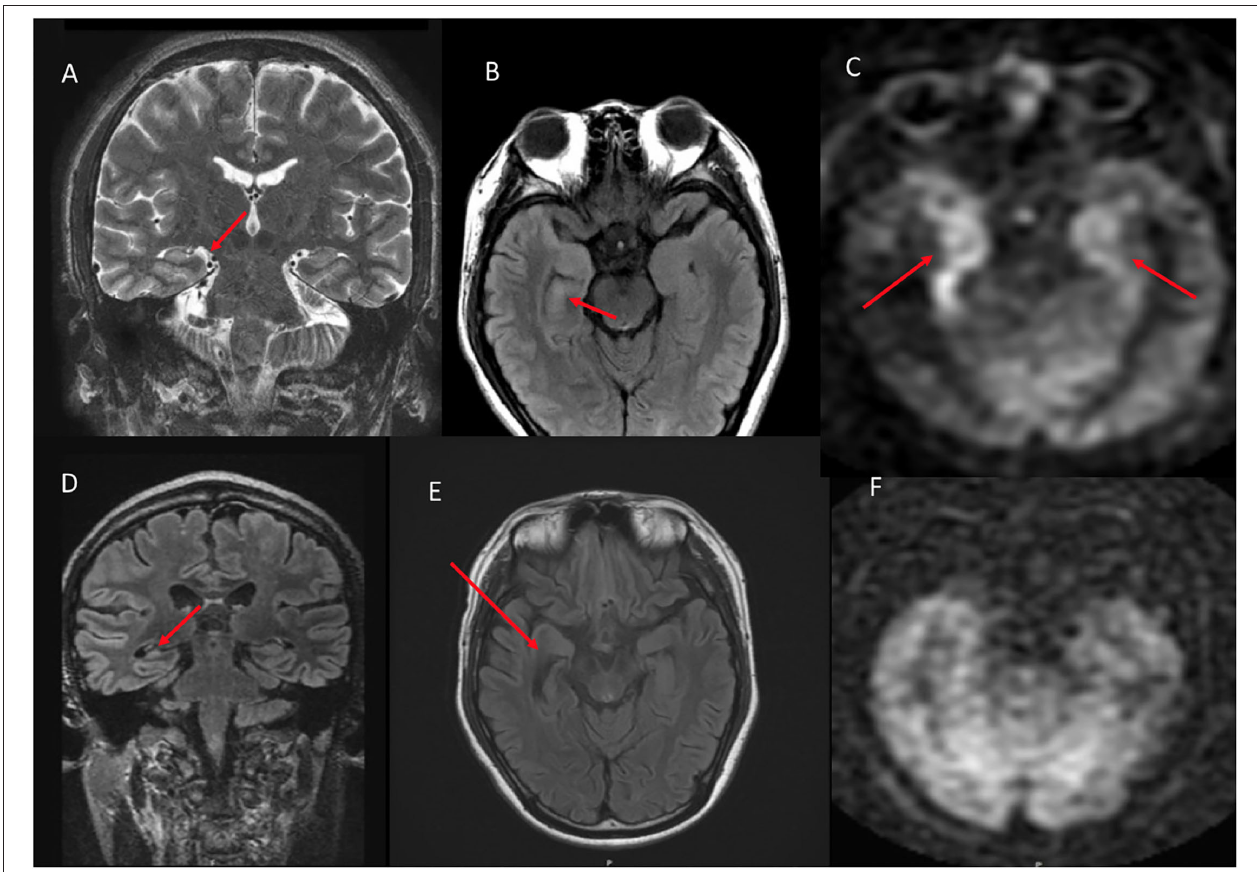
FIGURE 2 | A 28 year old male who presented with seizures and altered mental status. (A) Coronal T2W shows mild right hippocampal edema. (B) Axial FLAIR shows subtle right hippocampal and amygadala hyperintense signal. (C) ASL demonstrates asymmetric right greater than left hyperperfusion. (D) 10 month follow up coronal FLAIR shows right hippocampal volume loss. (E) Axial FLAIR shows right hippocampal volume loss with associated ex vacuo dilatation of the right temporal horn. (F) ASL demonstrates resolution of the previous right greater than left hyperperfusion.